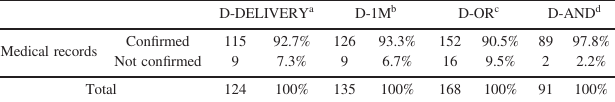
Table 3. Number and percentage of congenital anomalies in the Kochi subsample according to reporting